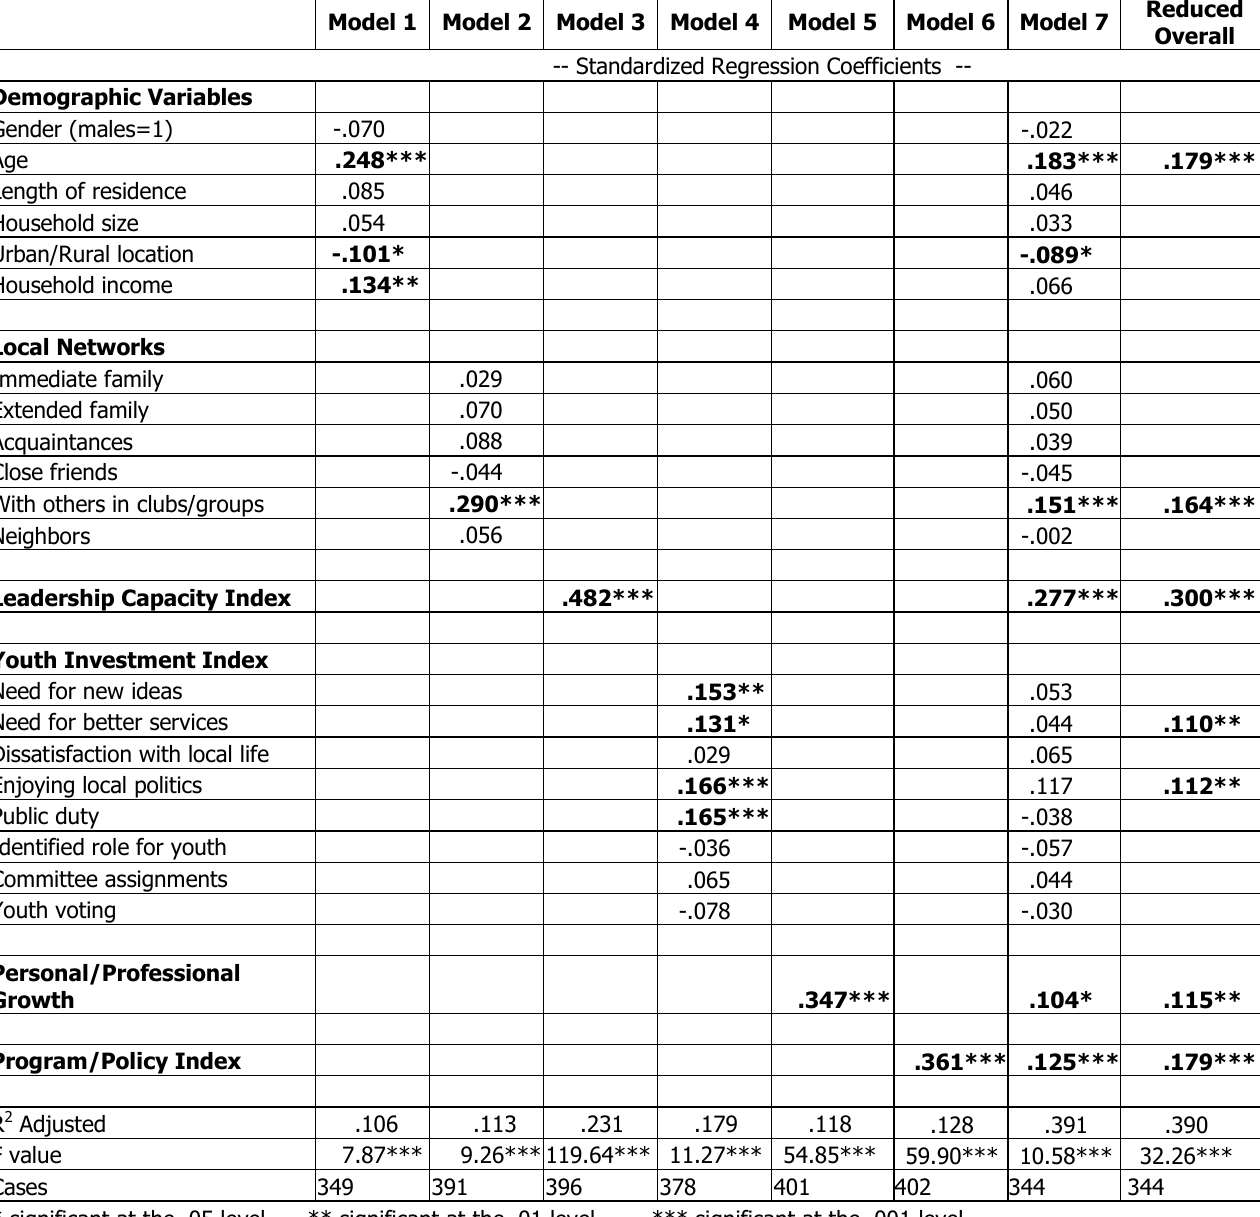
Comparison of Eight Multivariate Models on Youth Involvement in their